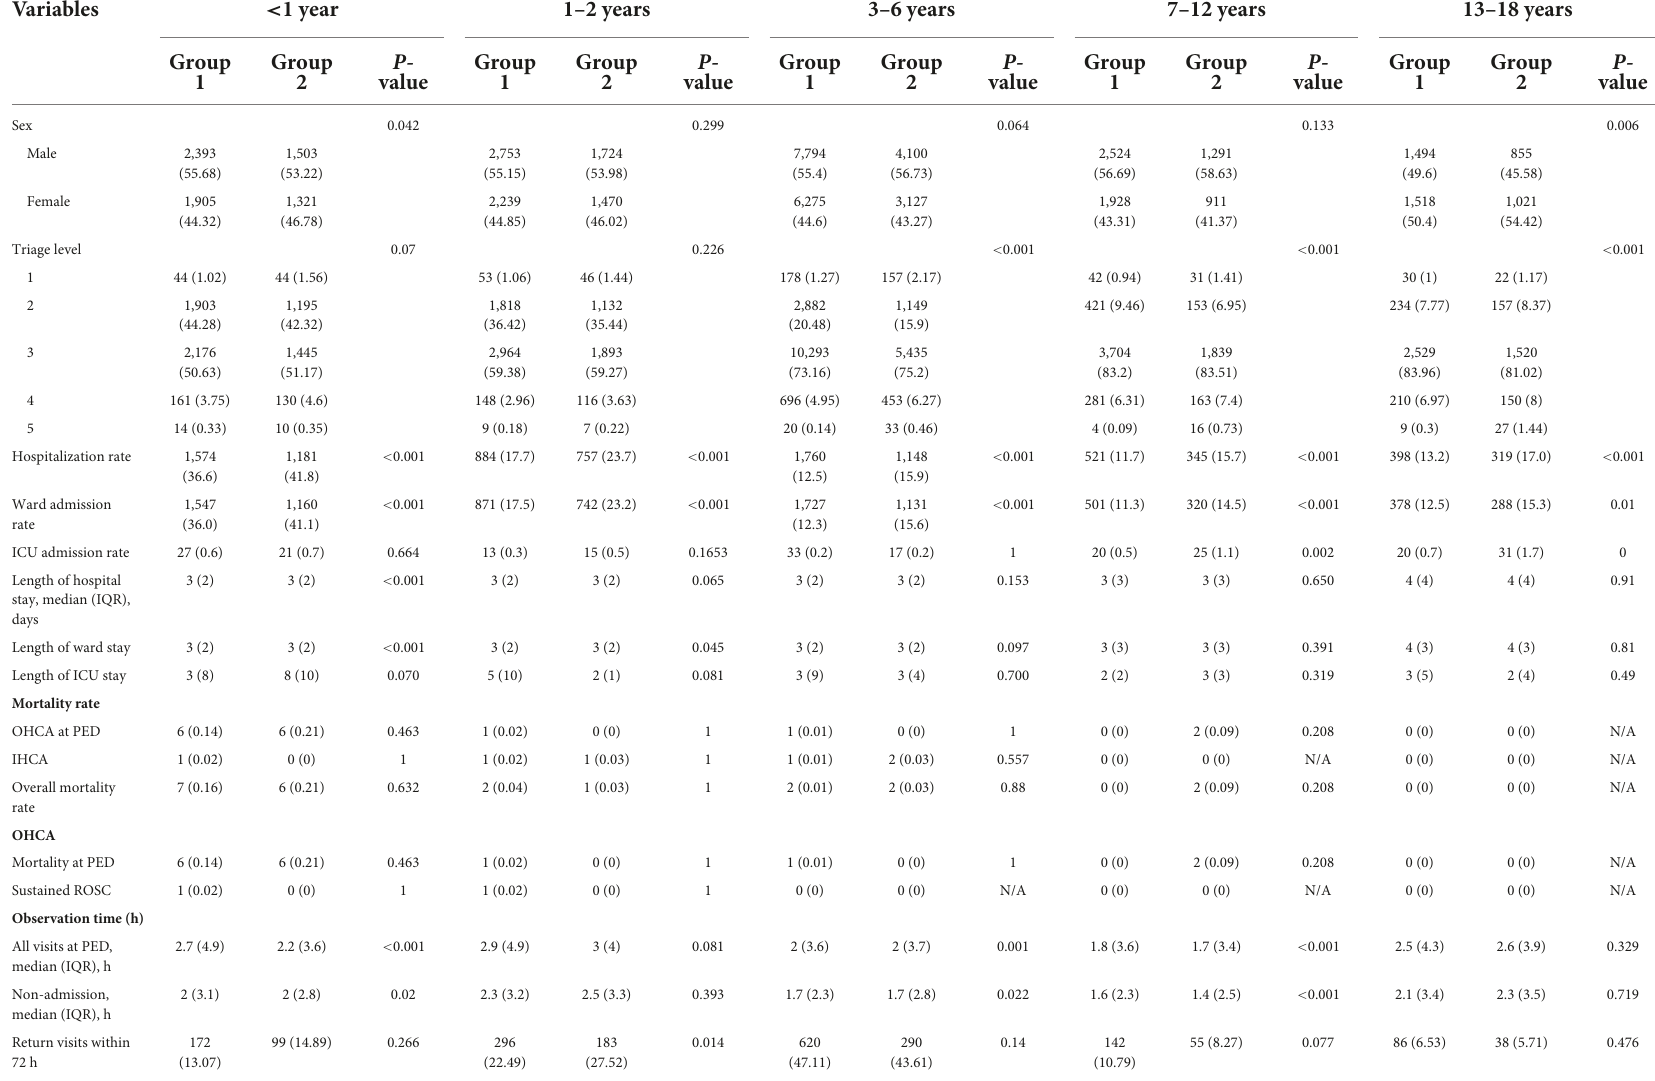
TABLE 3 Epidemiology of PED visits and resource use in different age groups in the 2020 pandemic period vs. the 2019 period [values are n (%)].